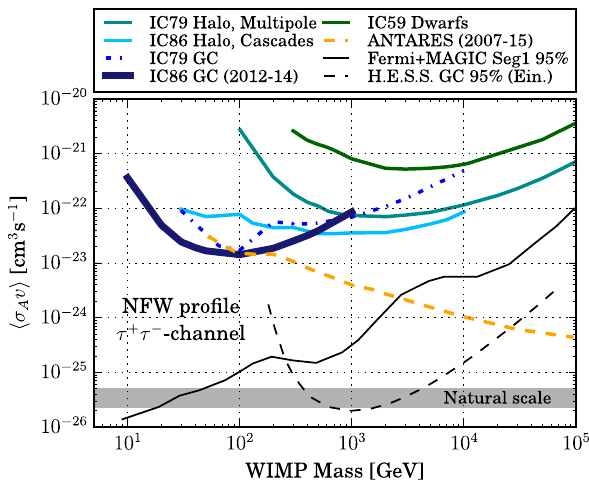
Fig. 30 Comparison of upper limits on (cid:11) σ A v (cid:8) versus WIMP mass, for the annihilation channel χχ → τ + τ − . IceCube results obtained with different detector configurations [255,264–266] are compared to ANTARES [267] and the latest upper limits from γ -ray searches from H.E.S.S. [268] and from a combination of Fermi-LAT and MAGIC results [269]. Figure from [270]